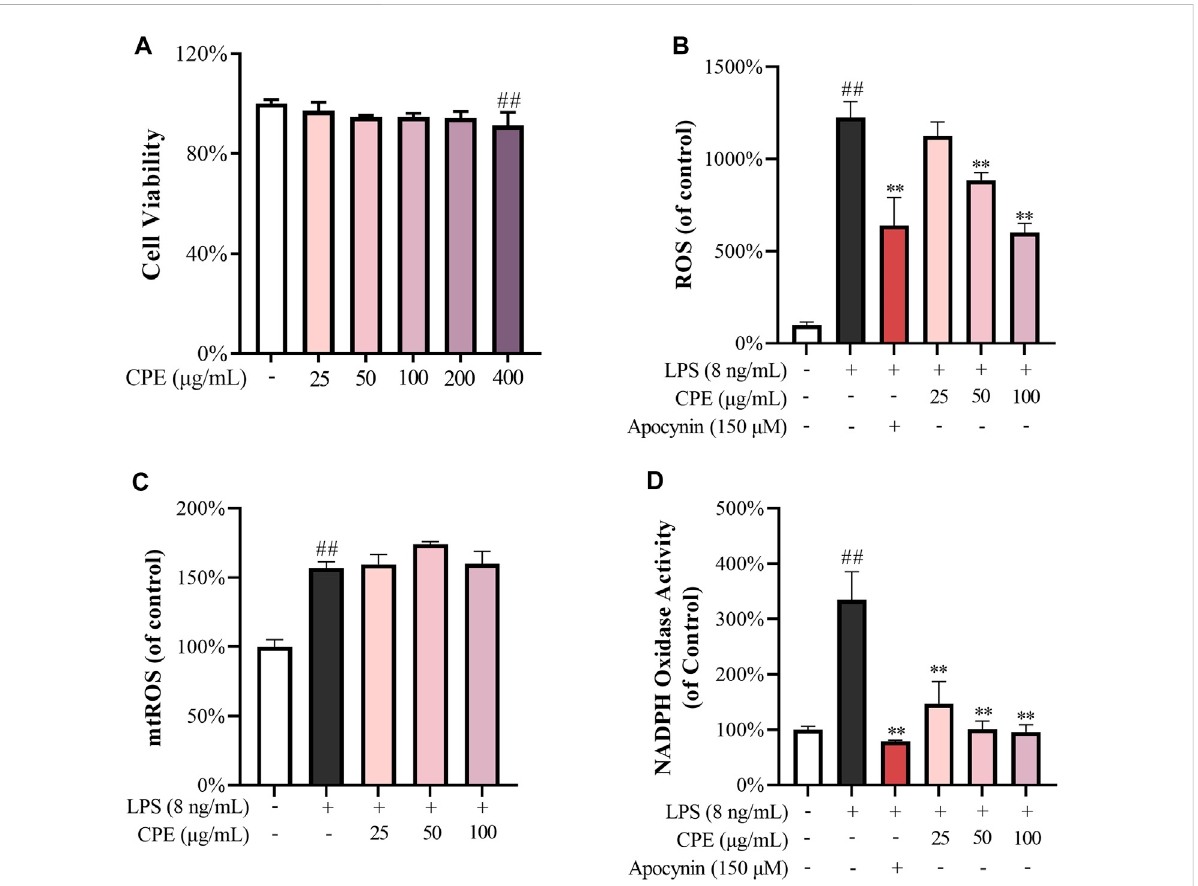
FIGURE 4 Effects of CPE on intracellular ROS ( n = 3). (A) Effect of CPE on the viability of RAW264.7 macrophages. The cells were treated with CPE at the indicated concentrations for 24 h and their viability was determined by MTS assay. (B) Effect of CPE on intracellular ROS. RAW264.7 macrophages were exposed to LPS (8 ng/ml) and treated with or without corresponding concentrations of CPE or apocynin (positive control) for 24 h. ROS level was determined using the chemiluminescence method. (C) Effect of CPE on mtROS. RAW264.7 macrophages were incubated with LPS (8 ng/ ml) in the absence or presence of CPE at the indicated concentrations for 8 h. The mtROS level was determined by using MitoSOX Red (5 μ M) as the fl uorescence probe ( λ λ ex 510 nm/ em 580 nm). (D) Effect of CPE on intracellular NADPH activity. RAW264.7 macrophages were treated with LPS (8 ng/ml) with or without CPE for 6 h. NADPH activity was determined using the chemiluminescence method. Apocynin was used as a positive control. ## p < 0.01 vs. normal control group; ** p < 0.01 vs. LPS alone